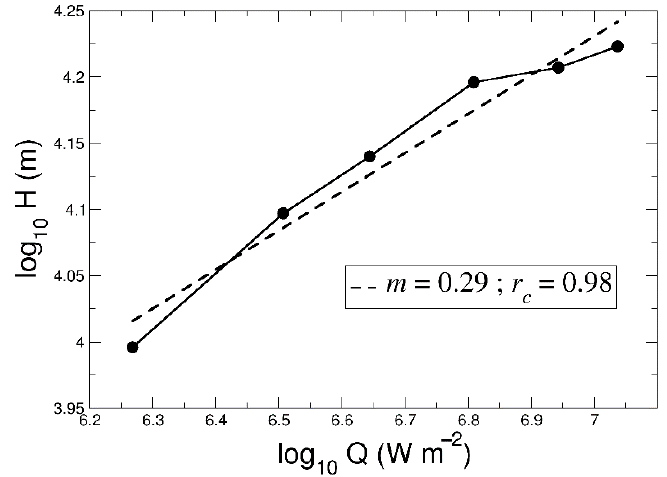
Figure 1. Dependence of plume height log H upon associated surface heat flux Q . The line of best fit connecting the simulated heights is marked with a dotted line and the inset text shows the gradient ( m ) and correlation coefficient ( r c ) for this best-fit line.